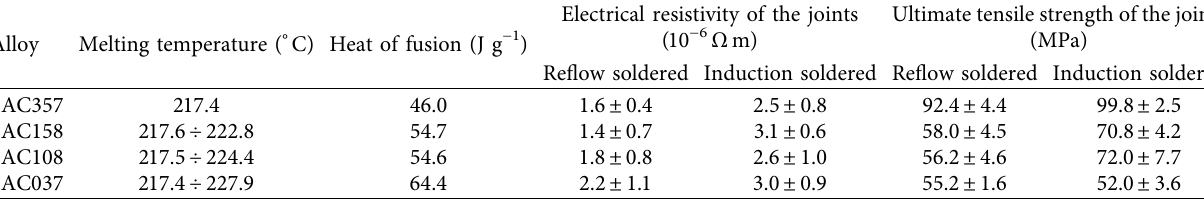
Table 2: Comparative table of the selected